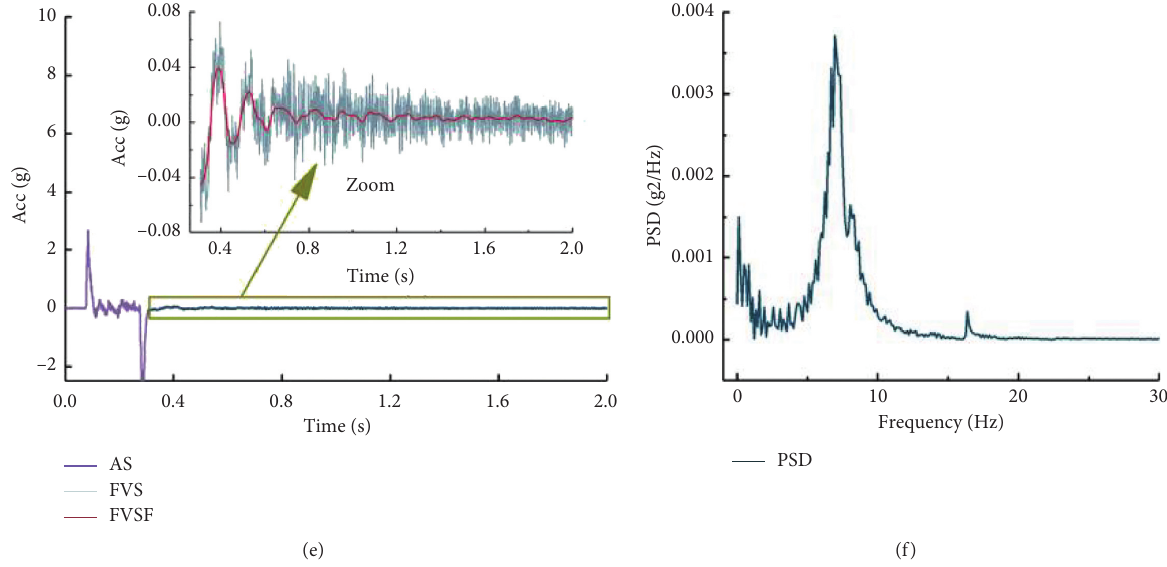
Figure 8: Residual vibration signal and PSD of FVSF for trapezoidal move profile impact with V a − � 2g; (c) and (d) a − � 2.5 g; (e) and (f) a − � 3g.